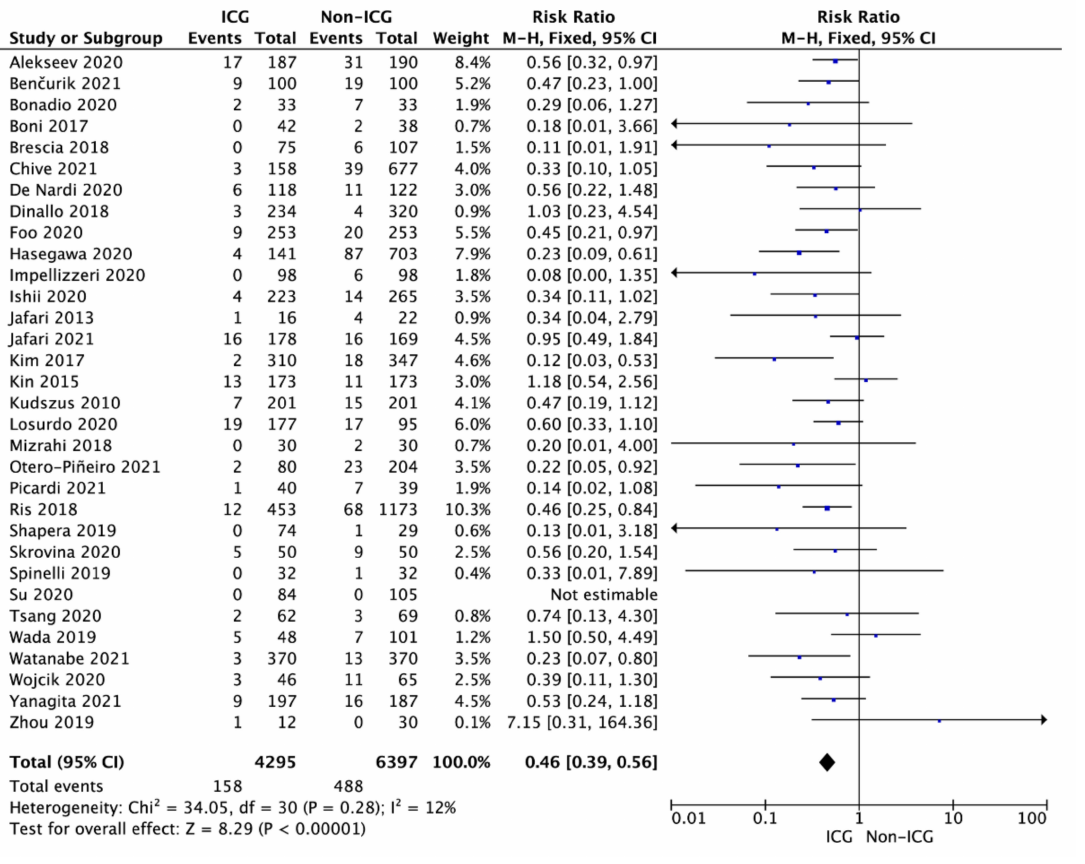
Figure 2. Forest plot of anastomotic leak occurrence in the ICG vs. non-ICG groups. The square centers represent the weighted risk ratios for individual trials, and the corresponding horizontal lines stand for the 95% CI. The diamonds represent pooled results. Legend: CI = confidence interval; ICG = indocyanine